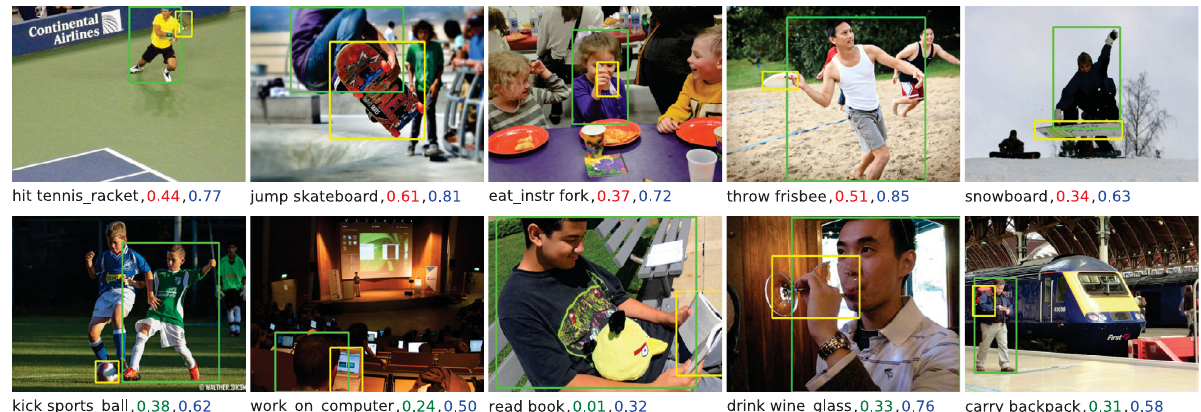
Fig. 5 Examples from V-COCO showing effectiveness of multi-level pairwise features. Red, green, and blue scores are results from the baseline model with the instance-level feature only, with instance-level and part-level features, and all features,